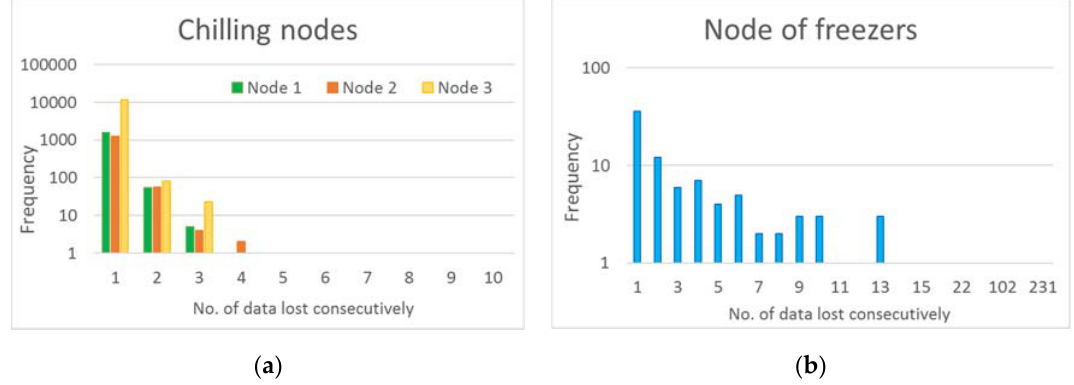
Figure 15. Data lost consecutively in chilling nodes ( a ) and the node of freezers ( b ) .